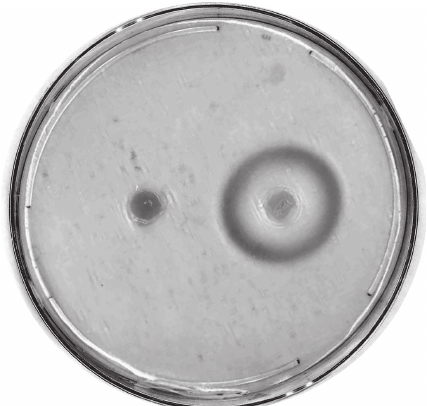
Figure 2: B. subtilis protease expression. Colonies transformed with either vector control (left) or aprE expression construct (right) were spotted onto LB agar plates containing 1% casein and 1mM